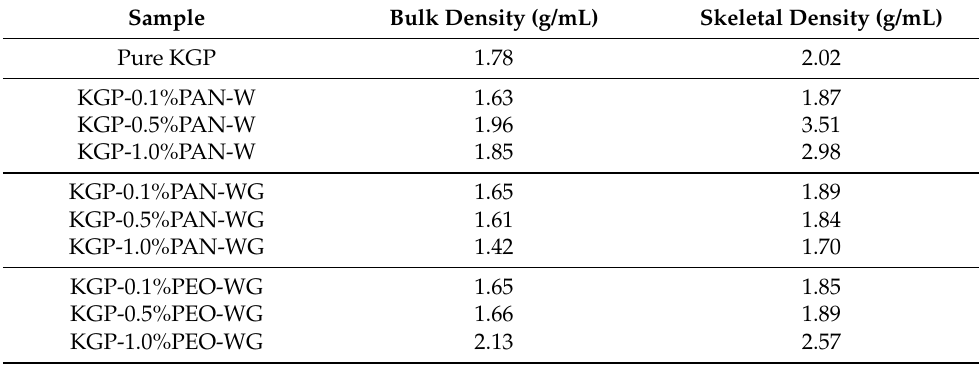
Table 4. Density of electrospun-fiber-reinforced geopolymer composites from MIP tests.